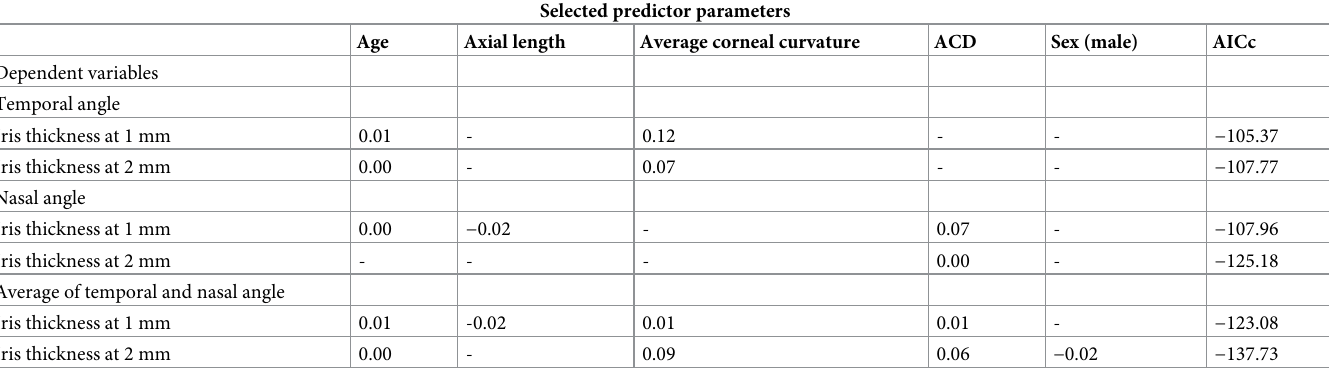
Number in each cell represents the coefficient